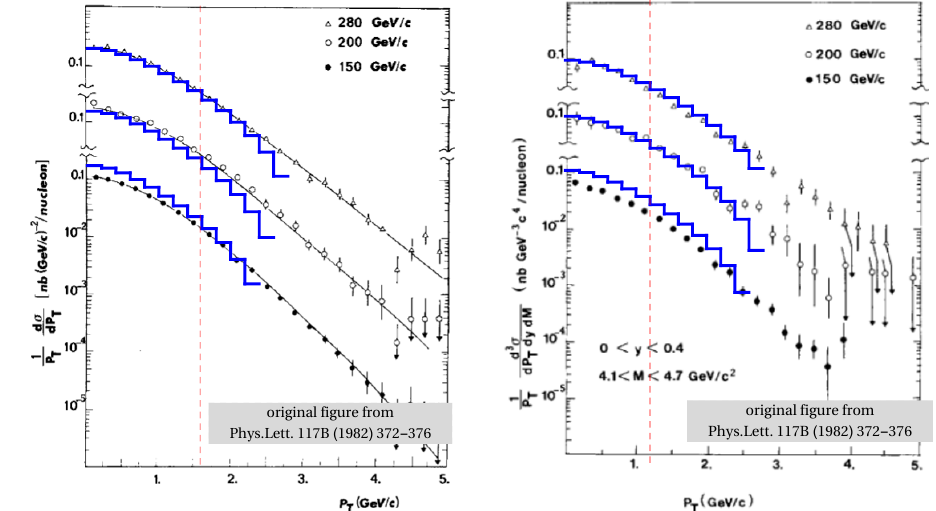
Figure 6 . Comparison of the theory prediction (solid line) to NA3 measurement. The theory prediction is plot on the top of (cid:12)gures 1 and 2 by ref. [39]. The vertical dashed line shows the estimation of the boundary for TMD factorization